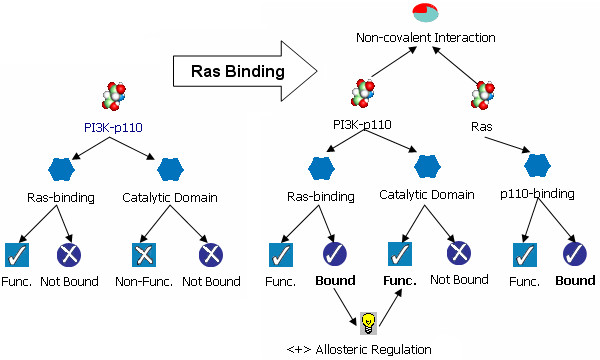
A model of a non-covalent interaction between a PI3K-p110 and a Ras. The figure was graphed from the developed SN to illustrate the relationships among different agents. The figure visualizes the agents as icons and their relationship as arrows. The left panel illustrates that a PI3K-p110 contains a "Not Bound" Ras-binding site and a "Non-Functional" catalytic domain. The right panel shows that when the PI3K-p110 has bound to a Ras, its Ras-binding site has switched to "Bound", and the catalytic domain has become "Functional" due to a positive allosteric regulation event. State changes as a result of the interaction are shown in bold. Note that the model stores the information, which specifies the non-covalent event between the prototypic Ras and the prototypic PI3K-p110, and the condition for the event to occur. This figure illustrates an instance of the Ras-binding event occurred during a simulation. The PI3K-p110 is an instance of the PI3K-p110 prototype, and it is the same agent before and after it binds to the Ras. Figure 8 shows the description of each icon.